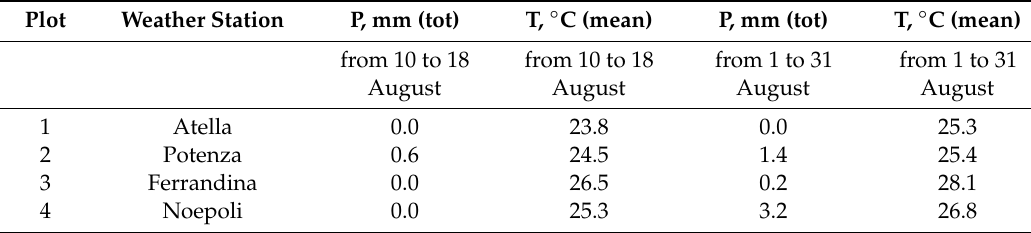
Table 4. Climatic data of the local meteorological stations within the four study plots.